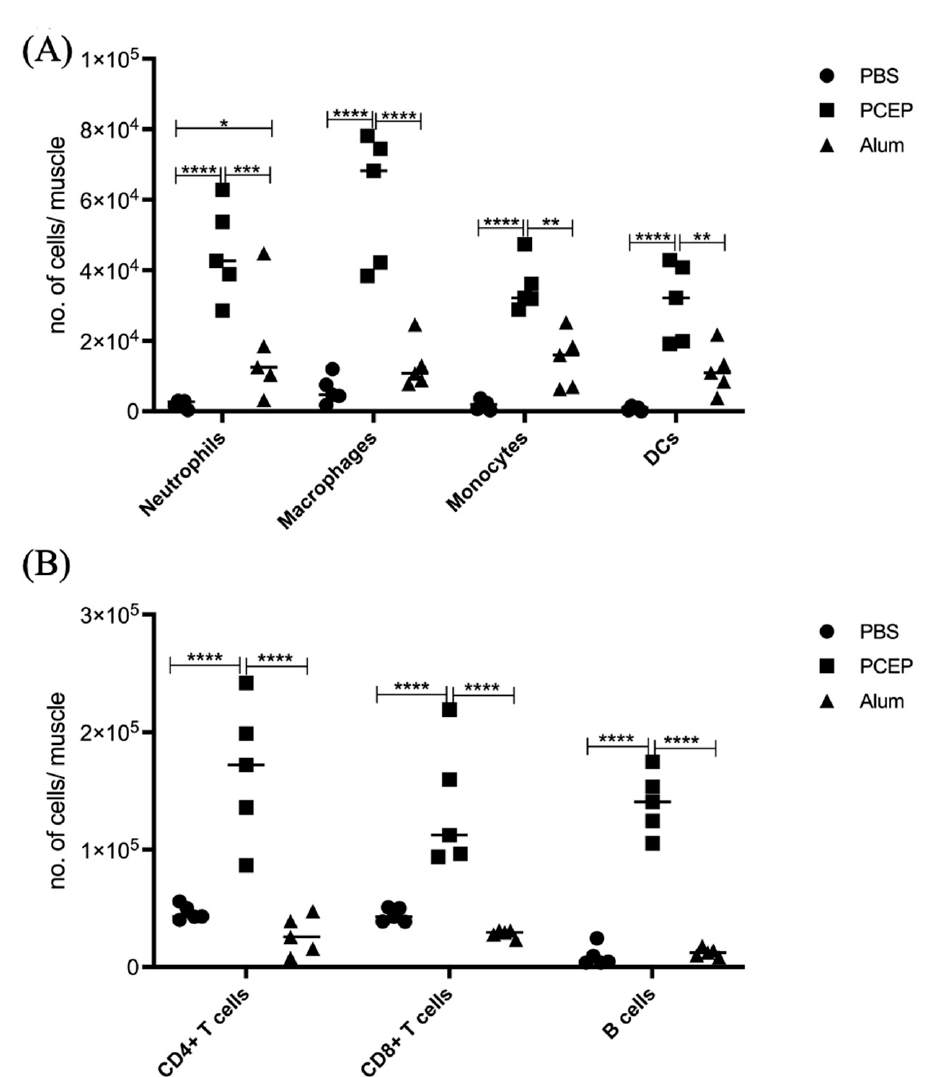
Figure 3. Patterns of Cell Recruitment to the Site of Injection in Response to Adjuvants. PCEP stimu- lates increased immune cell numbers at the site of injection. BALB/c mice ( n = 5 per group) were injected i.m. with either PBS, PCEP (50 ug) or alum (0.5 mg). The site of injection muscle tissue was dissected at 24 h time point and processed. Single cell suspensions were analyzed by flow cytometry. ( A ) Kinetics of myeloid cells (neutrophils, macrophages, monocytes and dendritic cells) 24 h post- injection of adjuvants at the site of injection. ( B ) Kinetics of lymphoid cells (CD4+, CD8+ and B cells) 24 h post-injection of adjuvants at the site of injection. Differences in the cell numbers were analyzed by two-way ANOVA and the significant differences between the treatments were compared by Bon- ferroni multiple-comparison test where **** p < 0.0001, *** p < 0.001, ** p < 0.005, * p < 0.05. (reprinted with modifications from Awate et al. 2014, Copyright 2014, with permission from